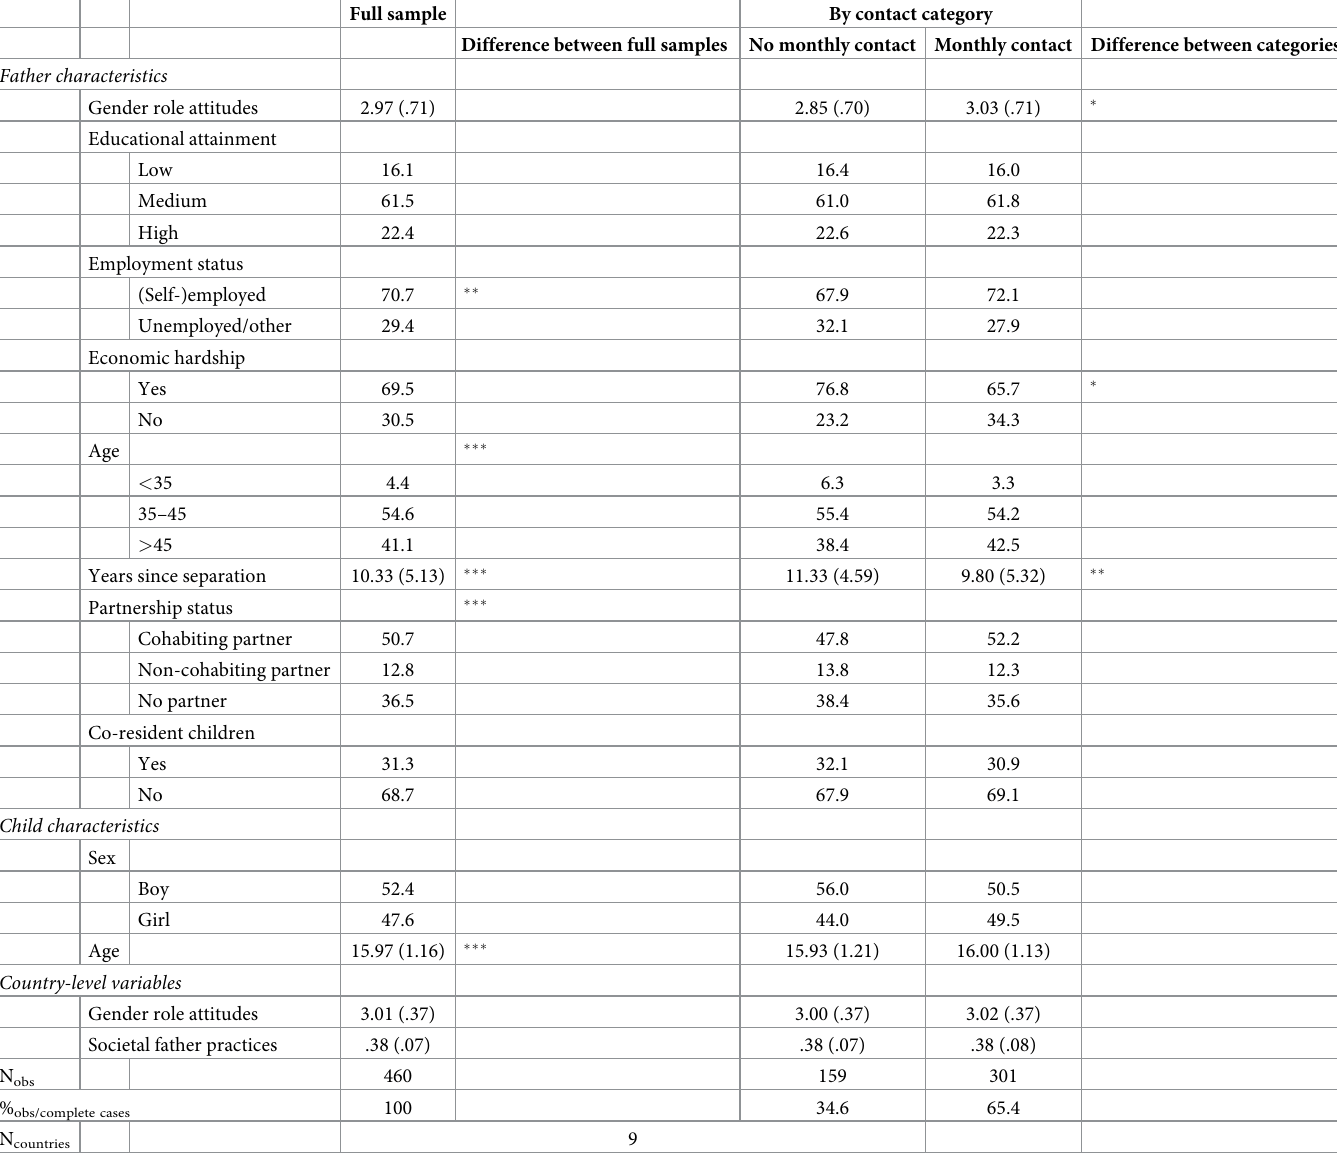
Table 4. Descriptive statistics for the adolescence-sample (percentage or mean and standard deviation (SD)). Full sample By contact category Difference between full samples No monthly contact Monthly contact Difference between